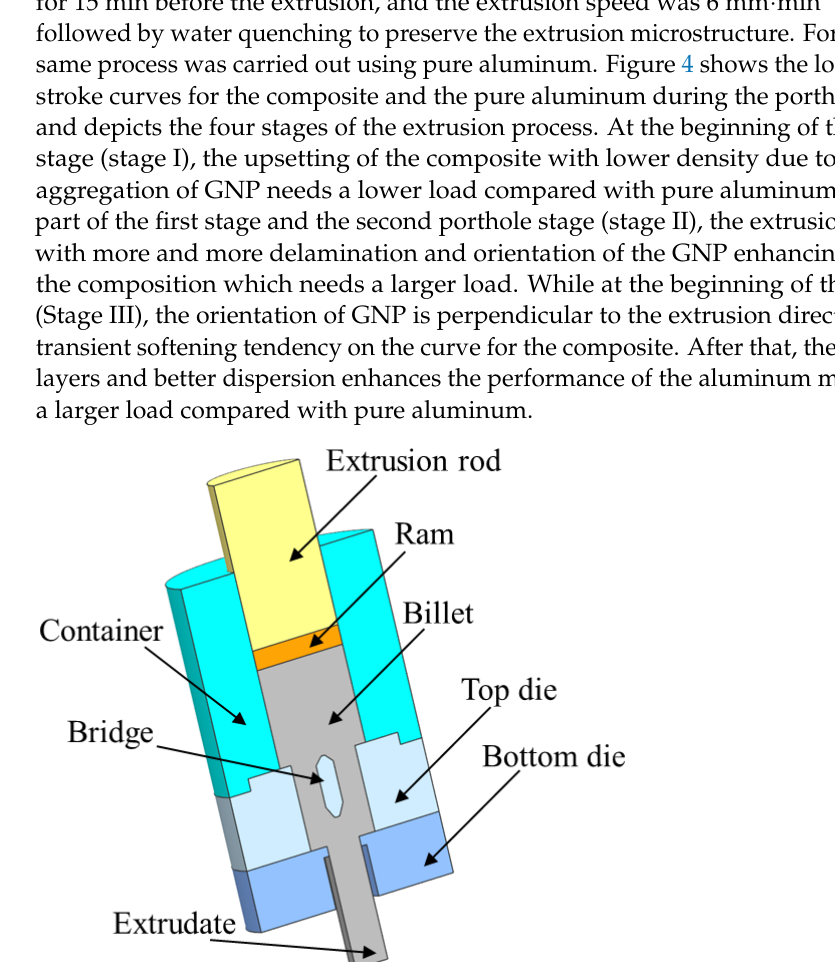
Figure 4. Load-displacement curve during the extrusion. 2.3. Microstructural Characterization An optical microscope (OM, 50X-1000X, ,) was used to observe the microstructural morphology of the composite extrudate. To this end, a sample with dimensions of 10 × 12 × 4 mm was used, as shown in Figure 5. Keller reagent was used for the corrosion of the samples. Electron backscatter diffraction (EBSD, FEI Quanta 650F, Thermo Fisher Scien- tific, Waltham, MA USA) observation of the sample was performed after ion thinning and electrolytic polishing to analyze the size, orientation, and misorientation angle of the grain, and the recrystallization of the composite. The morphology of the GNP and the interface in the welding region of the composite were characterized by field emission transmission electron microscopy (TEM, FEI Talos F200X, Thermo Fisher Scientific,